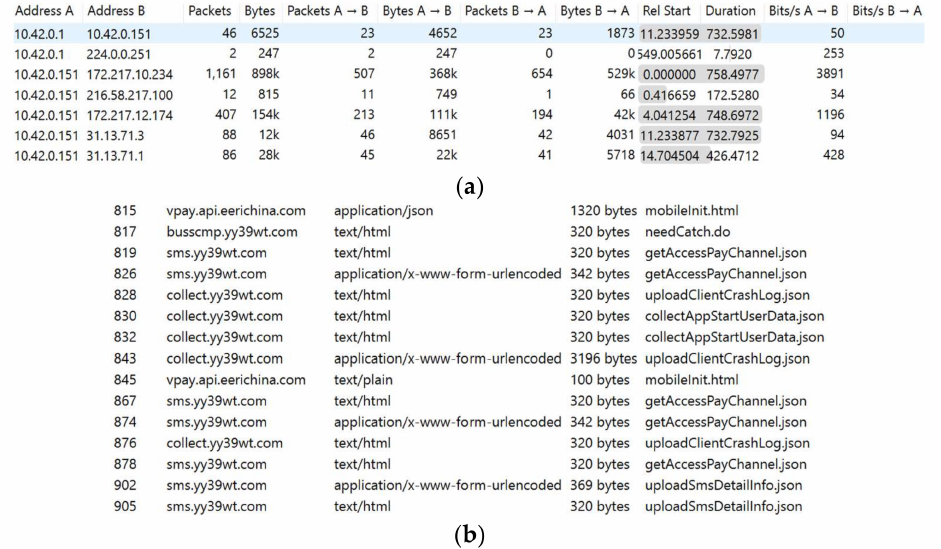
Figure 1. Malicious network patterns using adware and SMS malware: ( a ) malicious unresolved IP using adware; ( b ) malicious scripts using SMS